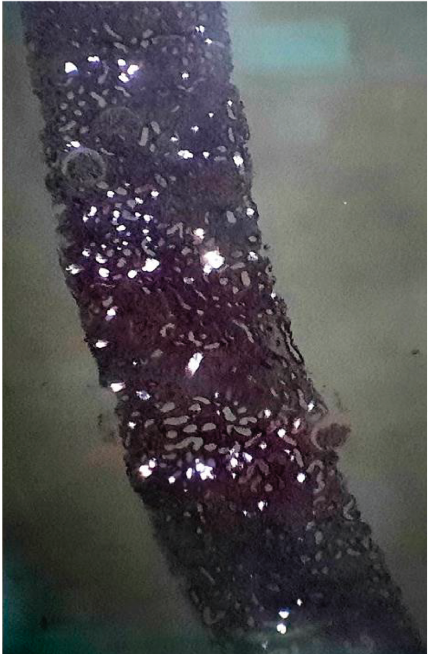
Figure 4: Partially polarized light microscopy (X100) shows diffuse birefringent intratubular casts.